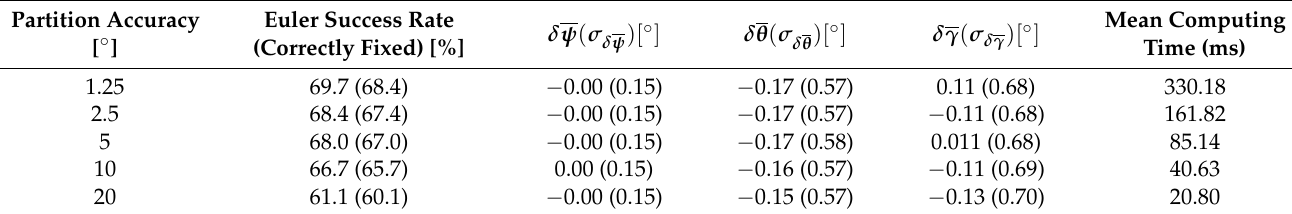
Table 7. Euler success rate with various steps for group 1.5 m in degraded